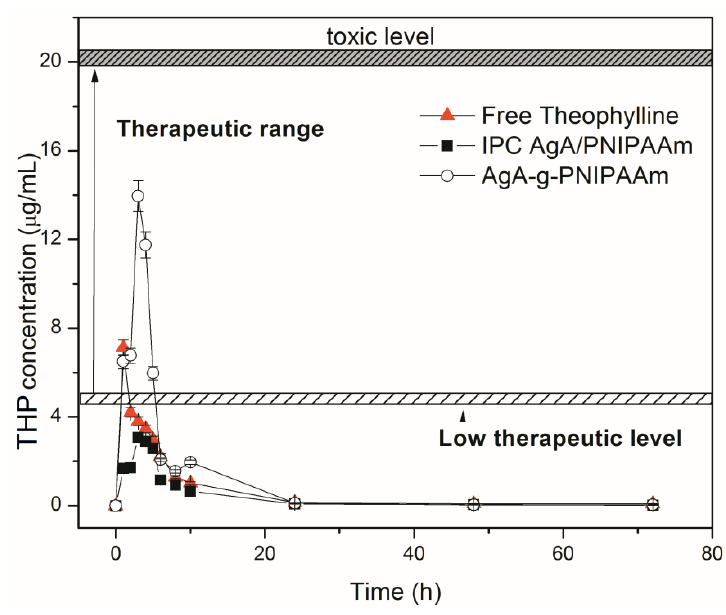
Figure 6. In vivo release profiles of theophylline from IPC 72/28-THP and C68-THP.